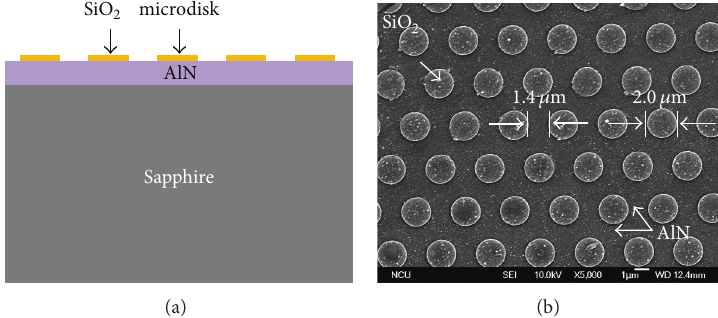
Figure 1: (a) Cross-sectional structure of patterned SiO 2 AlN/sapphire template. (b) Tilted SEM image of patterned SiO 2 AlN/sapphire